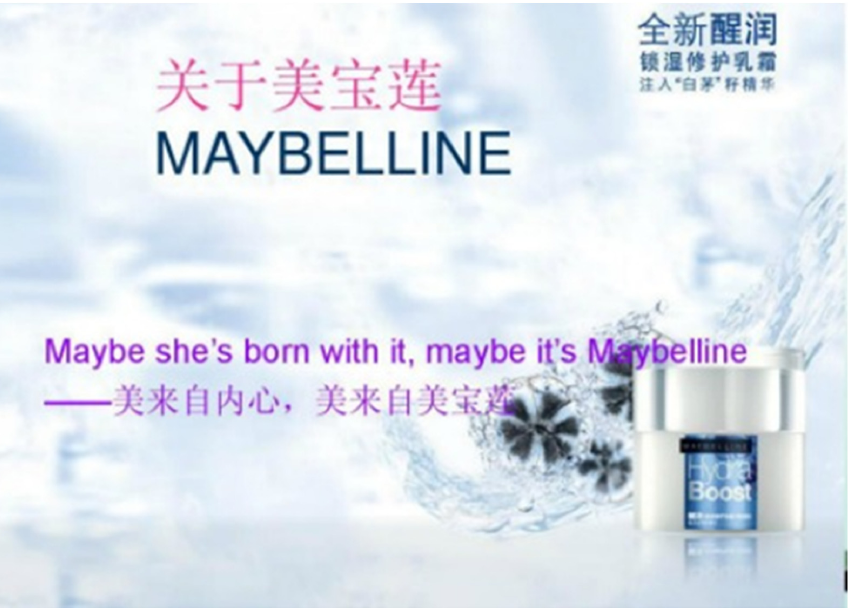
Figure 2. Sample two-sided advertising from China. Source : http://www.whatsonweibo.com/chineseadslogans/ (accessed on 11 June 2021).